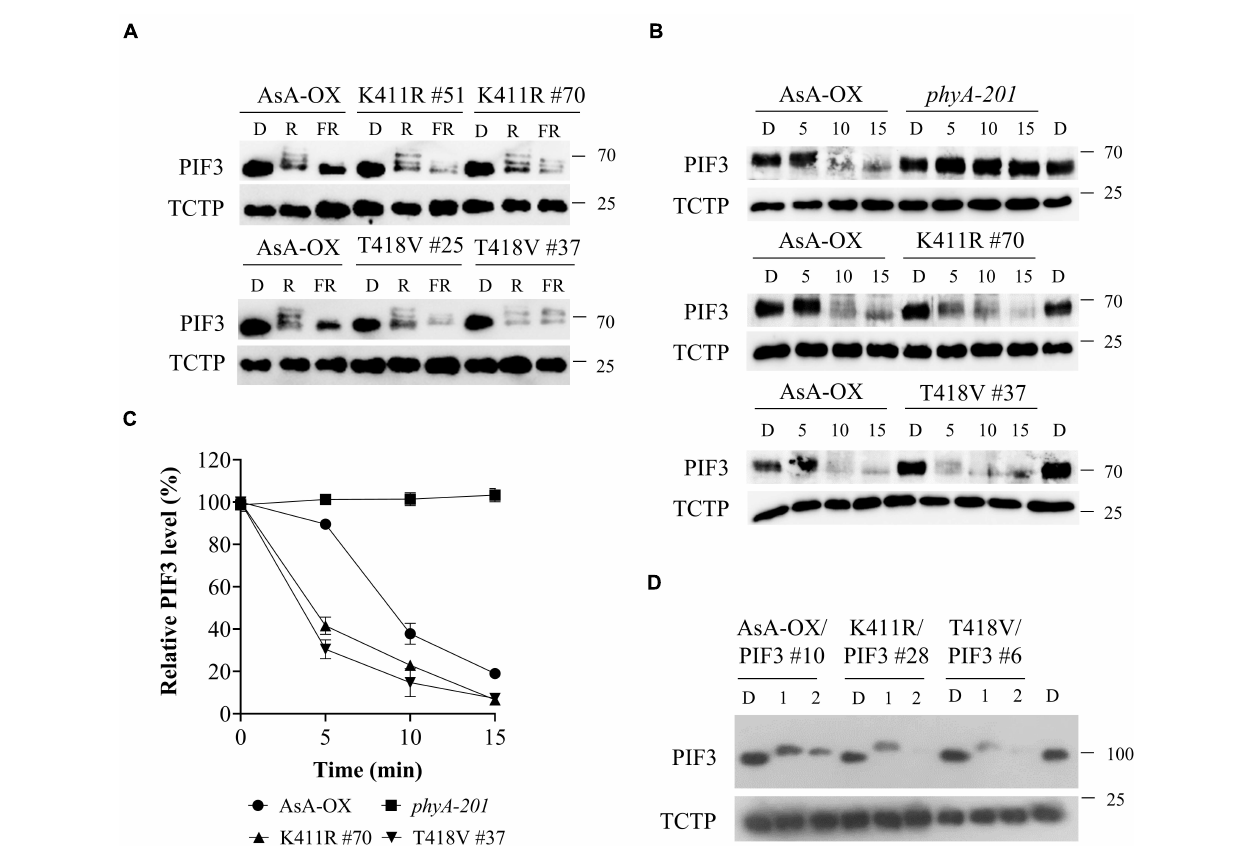
FIGURE 4 | FR light-induced phosphorylation and degradation of PIF3 in transgenic plants. (A) PIF3 degradation in transgenic plants expressing AsphyA under different light conditions. Four-day-old dark-grown seedlings were kept in the dark (D) or exposed to either red (R, 10 µ mol · m − 2 · s − 1 ) or far-red (FR, 5 µ mol · m − 2 · s − 1 ) light for 5 min before collecting samples for protein extraction. PIF3 protein was detected by western blotting using PIF3-specific antibody, and loading controls (TCTP) were shown in the lower panels. (B) Time-dependent degradation of PIF3 under FR light. Four-day-old dark-grown seedlings were kept in the dark (D) or exposed to FR (5 µ mol · m − 2 · s − 1 ) for the time indicated (5, 10, and 15 min), and PIF3-specific antibody was used to detect PIF3 in plants. (C) Relative PIF3 protein levels in (B) . Relative intensities of PIF3 protein bands were estimated from the blots using ImageJ, assuming dark samples as 100%. The intensities of TCTP protein bands were used for normalization. Data represent means ± SD from three independent measurements. (D) FR-induced phosphorylation and degradation of PIF3 using transgenic plants co-expressing AsphyA and eGFP-fused PIF3 (PIF3:GFP). Four-day-old dark-grown seedlings were kept in the dark (D) or exposed to pulsed FR light for 1 min (6,000 µ mol · m − 2 ) or 2 min (12,000 µ mol · m − 2 ), and incubated in the dark for 5 min before collecting samples for protein extraction. PIF3:GFP was detected by western blotting using GFP-specific antibody